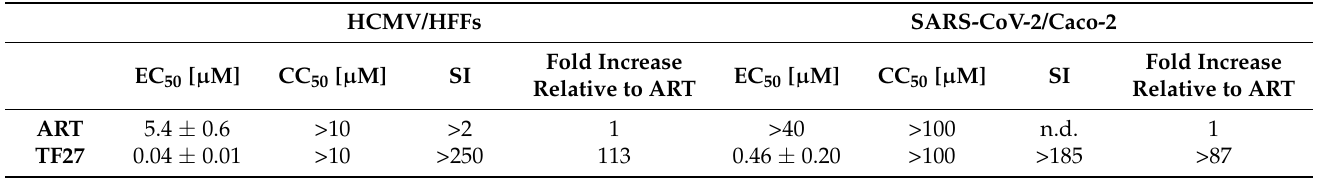
Figure 1. Anti-SARS-CoV-2 activity of ART and its optimized derivative TF27. ( A ) Chemical struc- tures depicting artesunate (ART) and its trimeric derivative TF27. ( B ) Human Caco-2 cells cultivated in 96-well plates at 25,000 cells per well were infected with the recombinant SARS-CoV-2 reporter virus d6-YFP at the MOI of 0.003 and treated with the indicated concentrations of compounds. At 28 h p.i., the cells were fixed using formalin and viral replication was determined by quantitation of the cell-associated YFP fluorescence. Cell viability was measured in parallel cultures of uninfected Caco-2 cells after 48 h of treatment by Neutral Red assay (NRA). The values represent means ± SD of the biological quadruplicates (viral replication) or triplicates (NRA/cell viability). Table 2. Comparative summary of in vitro antiviral activity, cytotoxicity, selectivity indices (SI), and fold increase in antiviral activity relative to the parental ART obtained for TF27 in HCMV and SARS-CoV-2 replication systems. The anti-SARS-CoV-2 EC 50 for TF27 represents the mean values of eight independent experiments based on YFP quantitations. EC 50 and CC 50 values for ART and TF27 in the HCMV/HFFs in vitro model have been reported earlier [10,20]. n.d., not